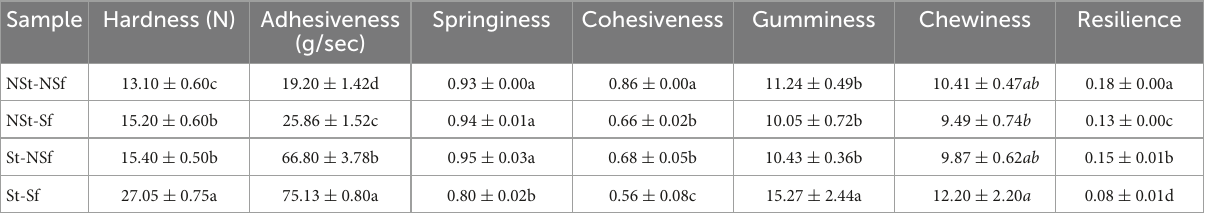
TABLE 2 Texture characteristics of starch gel.